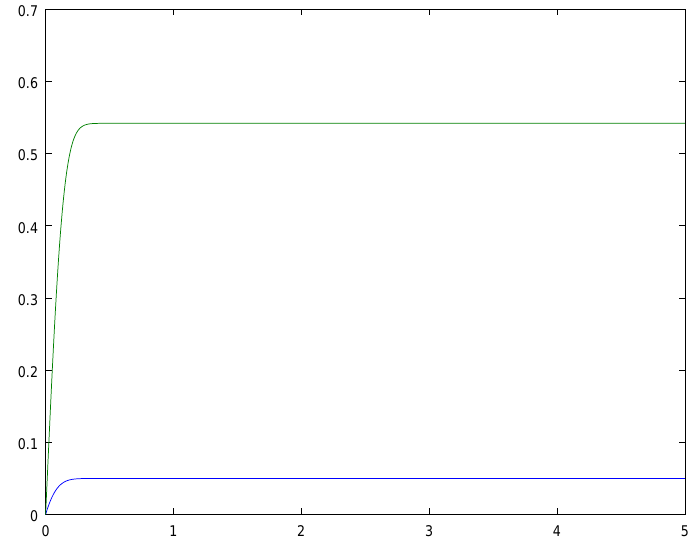
Figure 1. Example 1 (i). Time is marked on the horizontal axis, and the probabilities q 0 ( t ) (green) and ( t ) (blue) are marked on the vertical q 0 (cid:48)